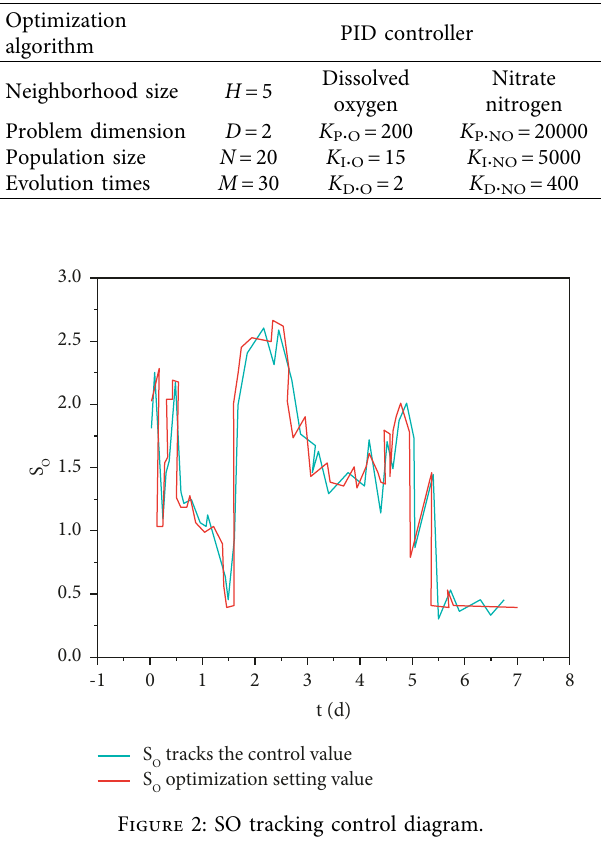
Table 4: Comparison of average effluent quality.